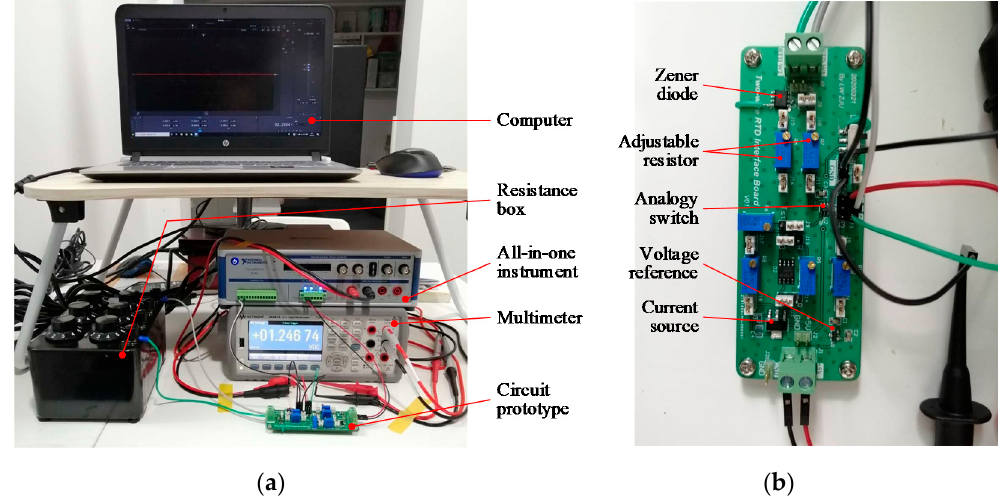
Figure 3. Schematic of RTD interface circuit.